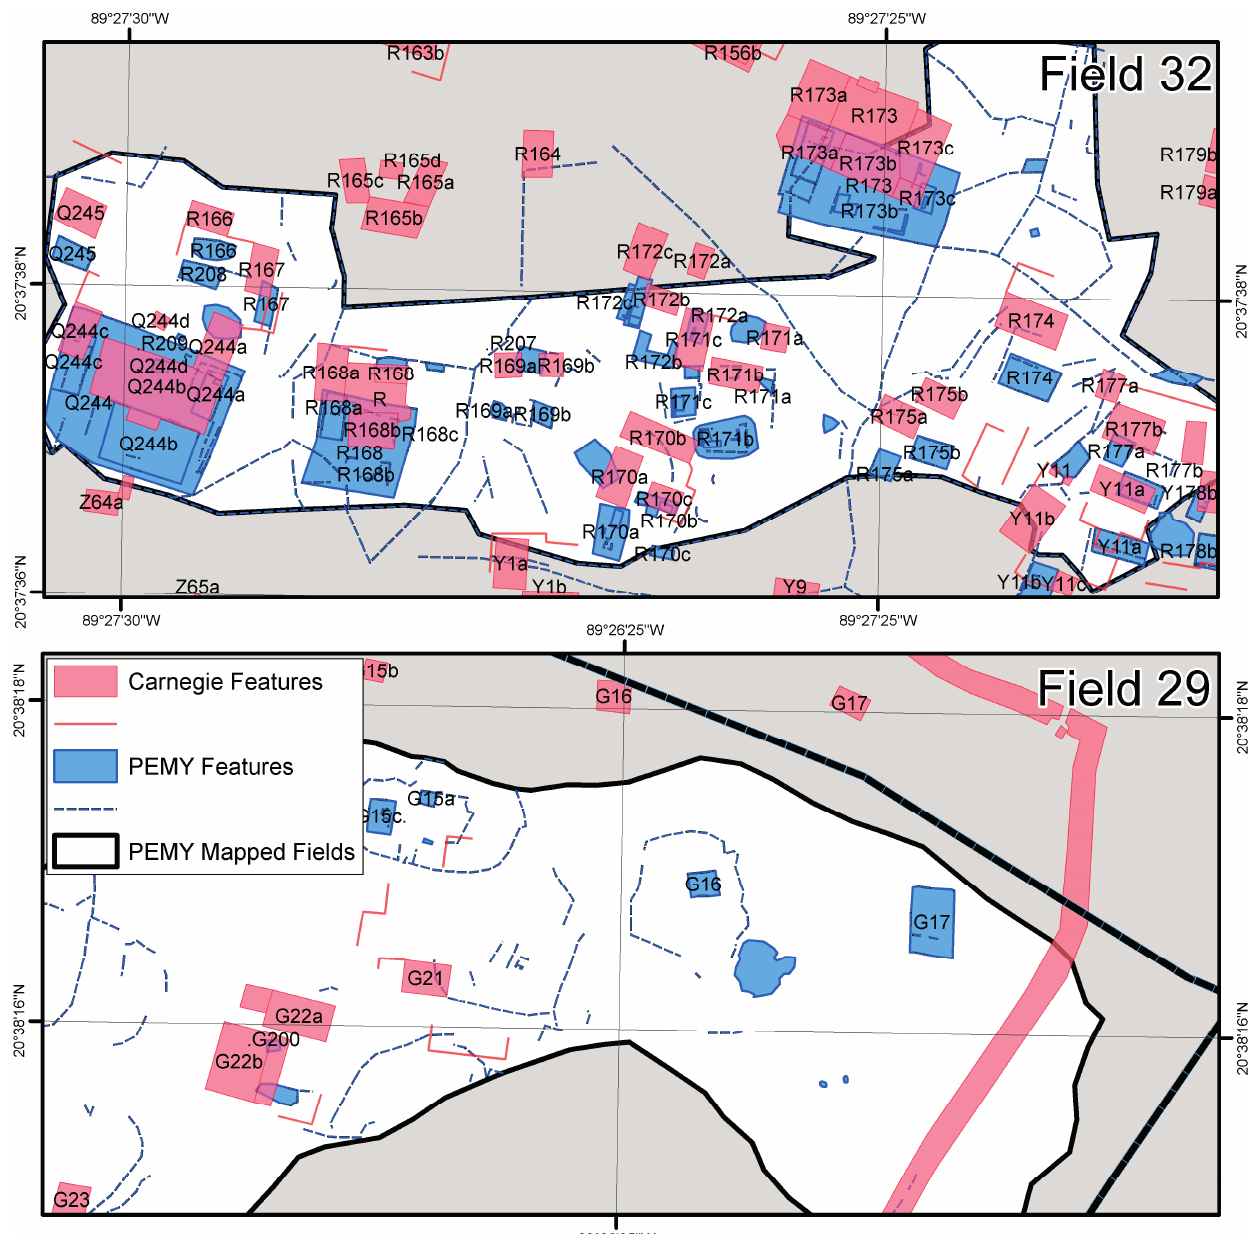
Figure 5. Comparison of Carnegie and PEMY maps of fields 29 and